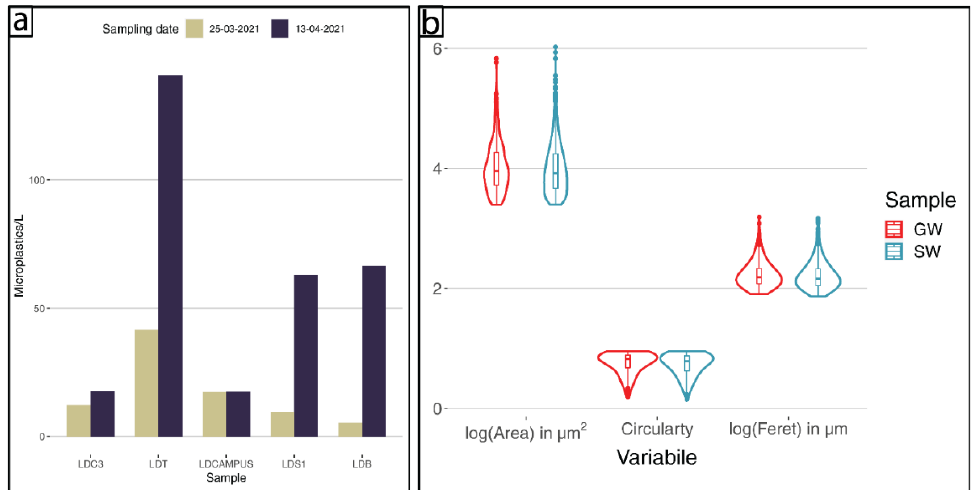
Figure 4. Microplastics characterization. ( a ) Microplastics occurrence (particles/L). ( b ) Microplastics’ geometric attributes in surface (SW) and groundwater (GW) samples; inside the violins, boxplots indicate the minimum and maximum values, lower and upper quartile, and median. Area and Feret diameter were log-transformed for graphical reasons.